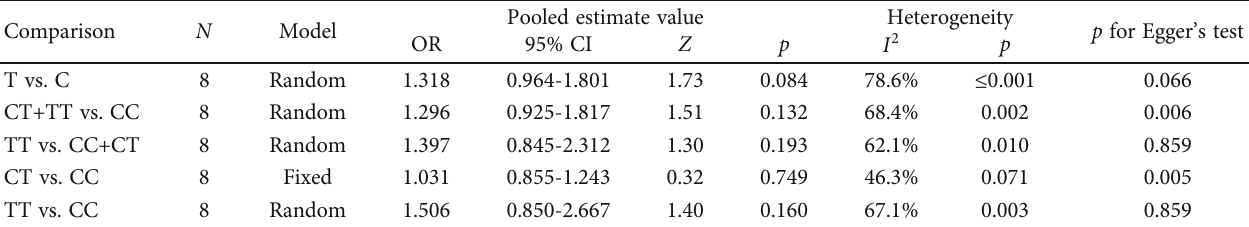
Table 3: Meta-analysis of the association between MTHFR C677T polymorphisms and MCI susceptibility and Egger ’ s test. Comparison